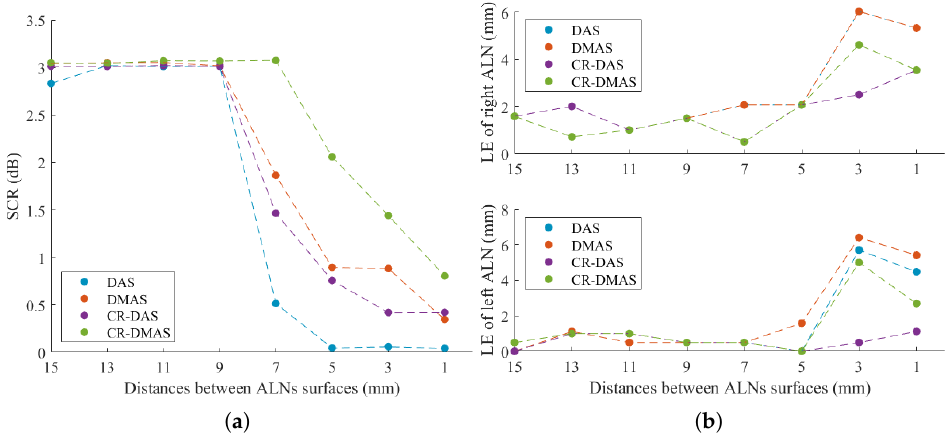
Figure 8. Plots of ( a ) Signal-to-Clutter Ratio (SCR) ratio and ( b ) Localization Error (LE) over distance between the surfaces of two metastasized ALNs.